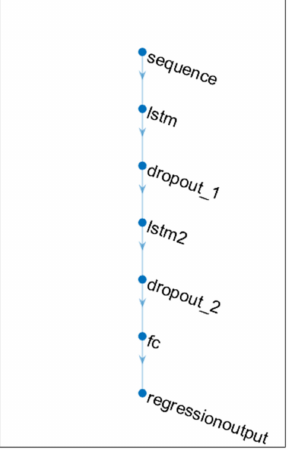
Figure 7. The LSTM